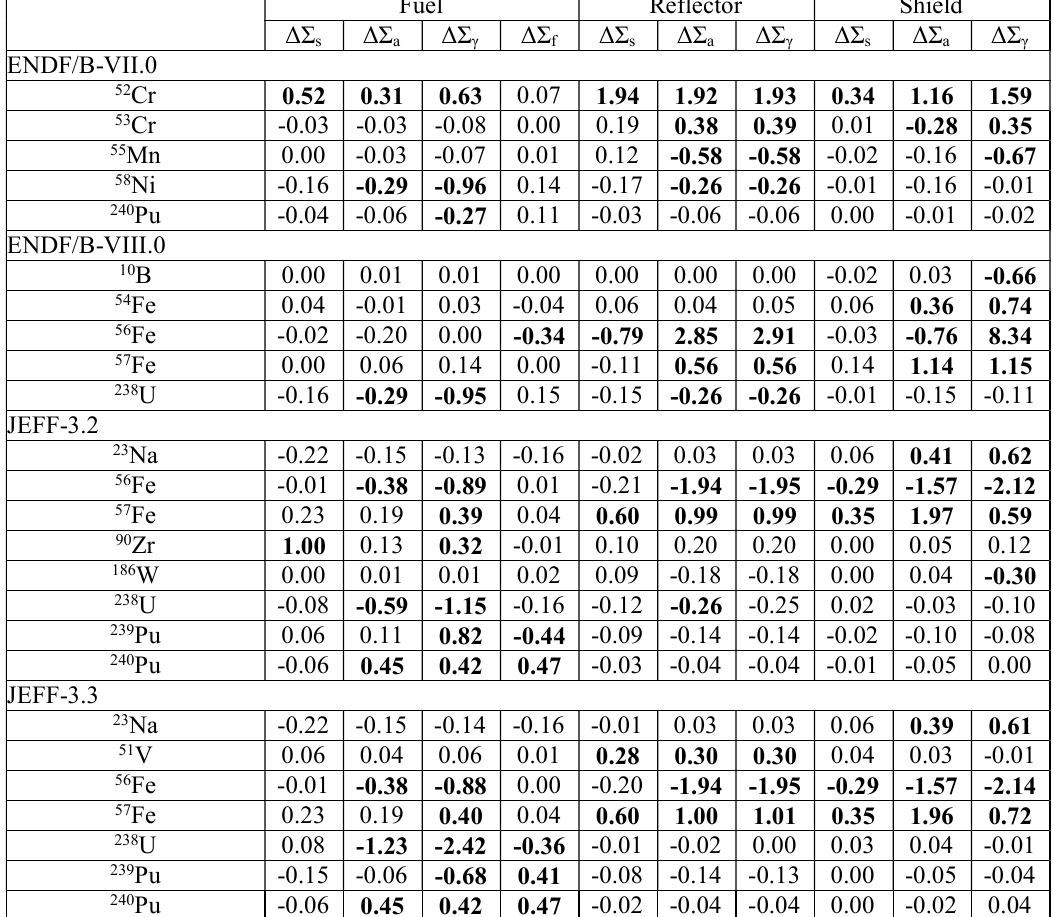
Table III. Cross section impact due to isotopic substitution: Relative percent difference in scattering, absorption, (n,γ) capture, and fission macroscopic cross section from isotopic substitutions in